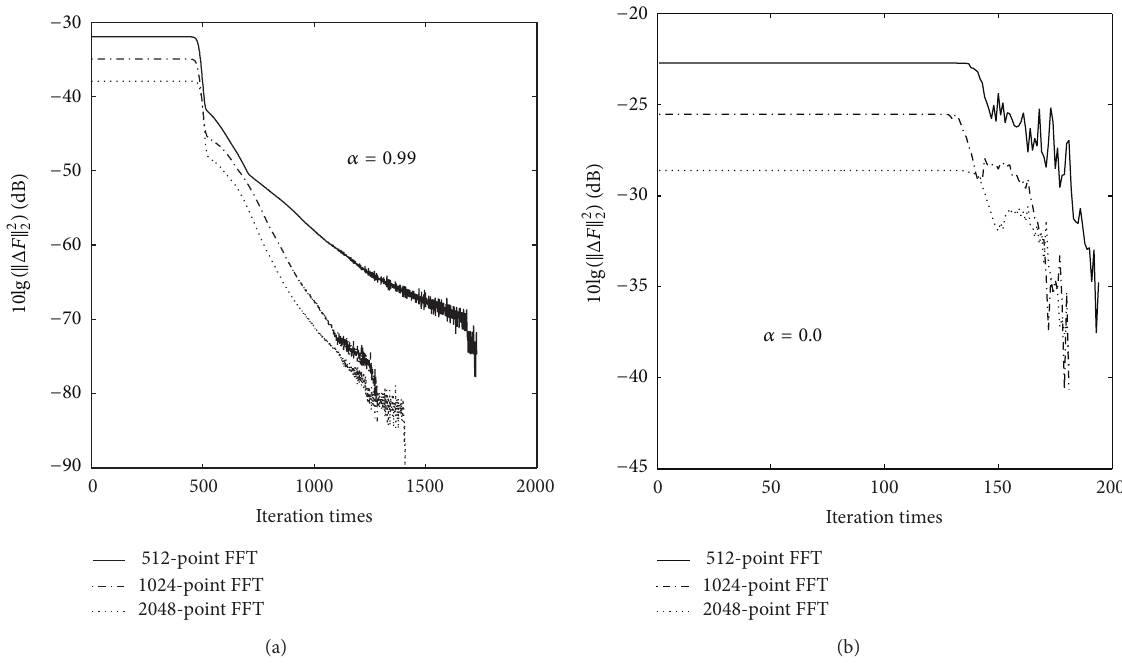
Figure 4: Norm of the error pattern for the phase-only tapering: (a) 𝛼 = 0.99 and (b) 𝛼 = 0.0